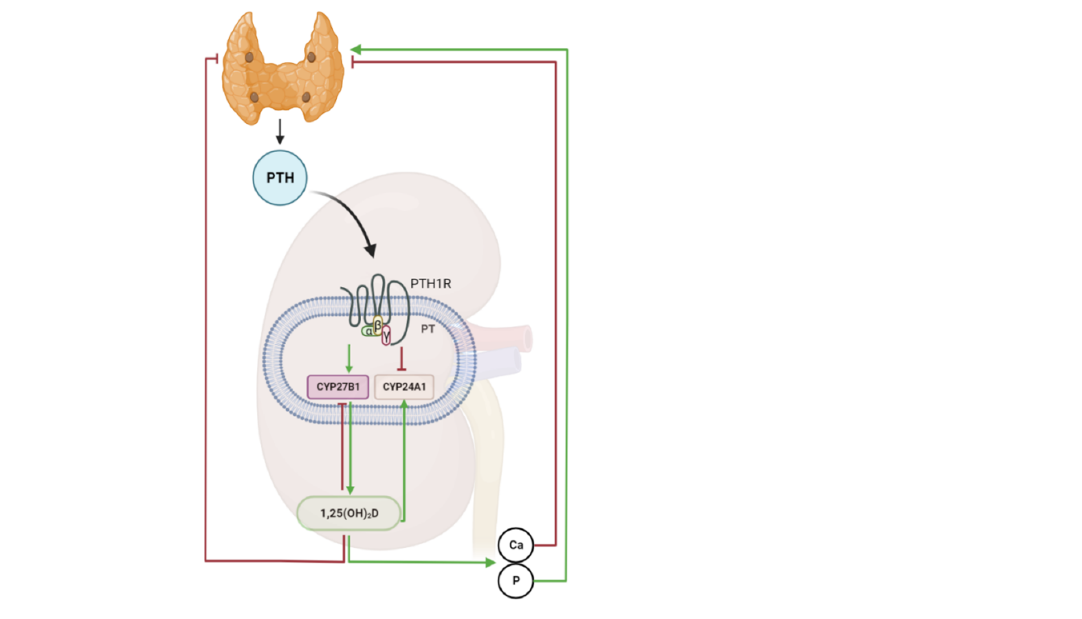
Figure 1. Parathyroid-kidney axis. Parathyroid hormone (PTH) secretion from the parathyroid gland is increased in response to a decrease in ionized plasma calcium (Ca) or to an increase in the blood concentration of inorganic phosphate (P). PTH binds to the parathyroid hormone-1 receptor (PTH1R) in proximal tubules (PT) of the kidney, promoting 1,25(OH) 2 D production by upregulating 1 α -hydroxylase ( Cyp27B1 ) and suppressing 24-hydroxylase ( Cyp24A1 ) expression. As part of a feedback inhibition, 1,25(OH) 2 D downregulates its own production by stimulating Cyp24A1 and inhibiting Cyp27B1 expression in the kidney. Circulating 1,25(OH) 2 D signals back to the parathyroid gland, where it inhibits PTH transcription and secretion. Arrows indicate the direction and nature of regulation (green, stimulation; red, inhibition). Created with BioRender.com.(Biorender 2022, Toronto, Ontario,